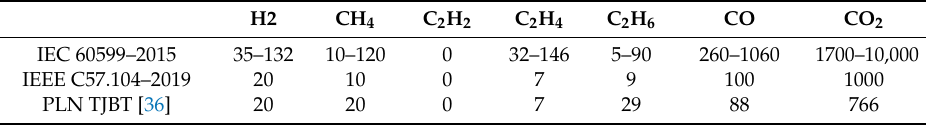
Table 6. Comparison of typical rate of gas increase on normal level (ppm / year).